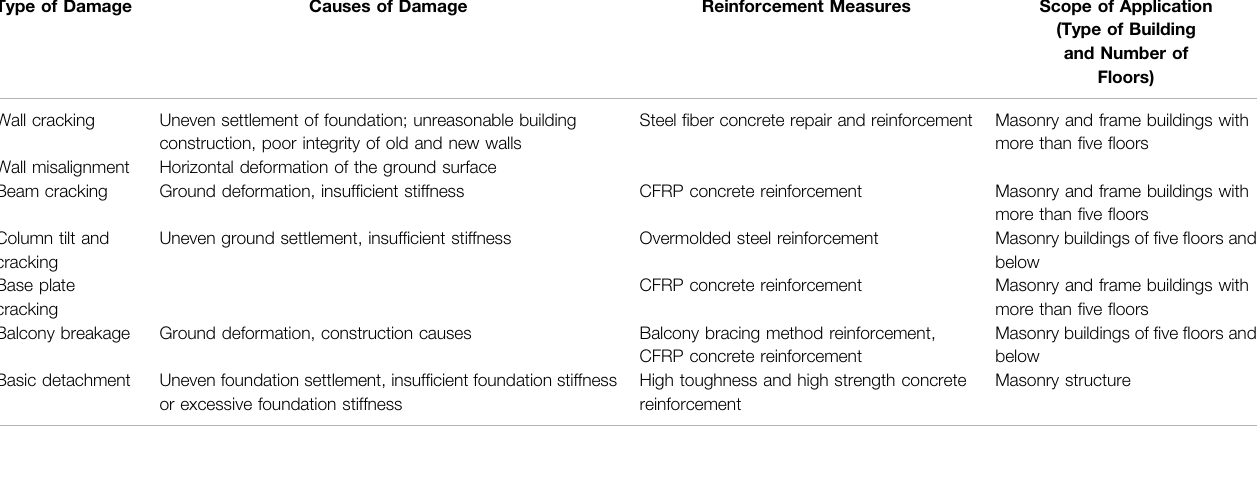
TABLE 4 | Causes of damage to building elements and reinforcement measures in each region.